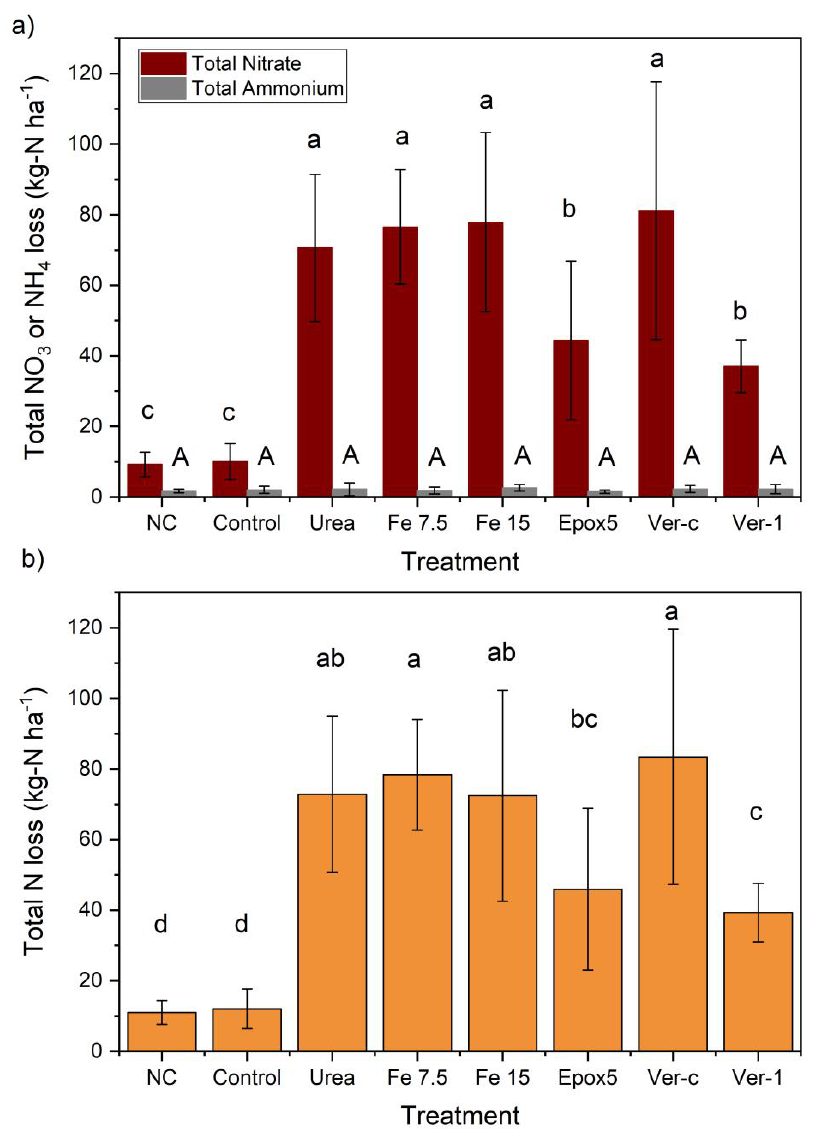
Figure 3. ( a ) Total nitrate and ammonium losses and ( b ) total N losses of different treatments. Error bars indicate the standard deviation ( n = 5). The letters show a significant difference between the treatments at p <